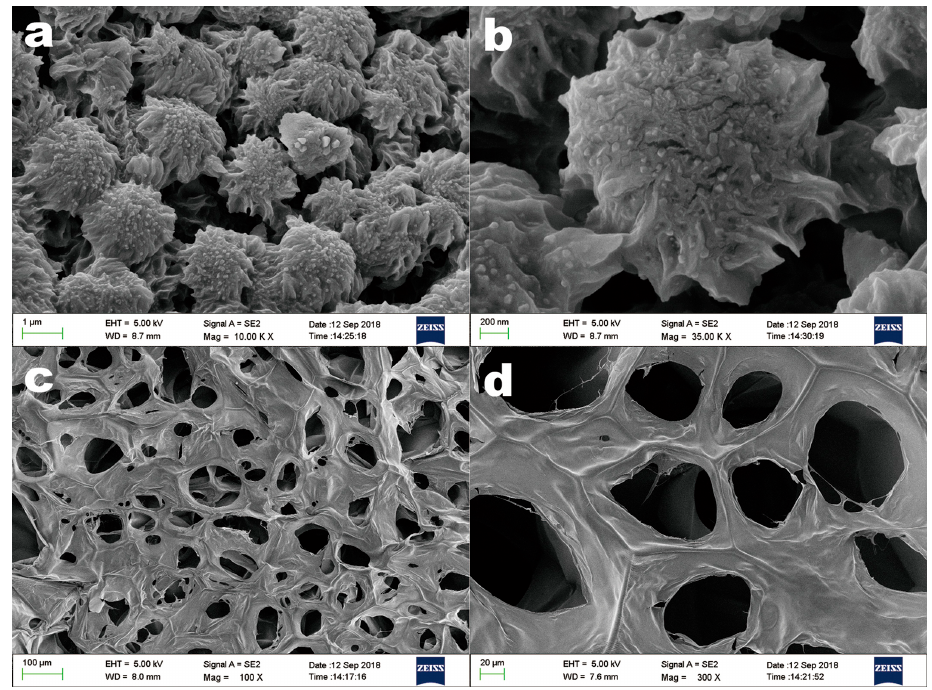
Figure 3. Transmission electron microscopy (TEM) images of nanocomposites. ( a ) PAMAM G5.NH 2 ; ( b ) PAE/mPEG-PAMAM G5.NHAc; ( c ) high resolution image of a single PAE/mPEG-PAMAM G5.NHAc; ( d ) the image of PAE/mPEG-PAMAM G5.NHAc based DGG (deacetylated gellan gum) in situ gel.